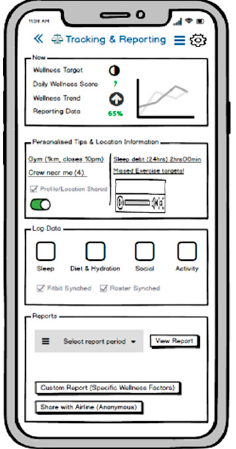
Figure A9. Tool 1: Tracking and reporting dashboard.